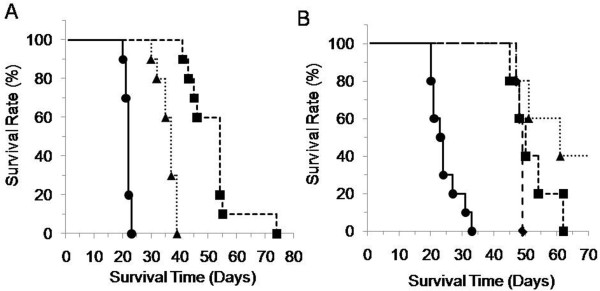
Survival time of the ES-2 peritoneal metastasis mouse model after treatment with CPT-11 or IHL-305. ES-2 cells (2 x 105 cells) were inoculated into the peritoneal cavity of mice on day 1. (A) Saline as the vehicle control (●), CPT-11 (45 mg/kg/day: ▲) or IHL-305 (45 mg/kg/day: ■) was administered on days 4, 8, and 12, and the survival time was analyzed (n=10, each group). (B) Saline was administered as the vehicle control (●). IHL-305 (45 mg/kg) was administered on days 4, 8 and 12 (schedule A, ▲), days 8, 12 and 16 (schedule B, ■) or days 12, 16 and 20 (schedule C, ♦), and the survival time was analyzed (n=5, each group).